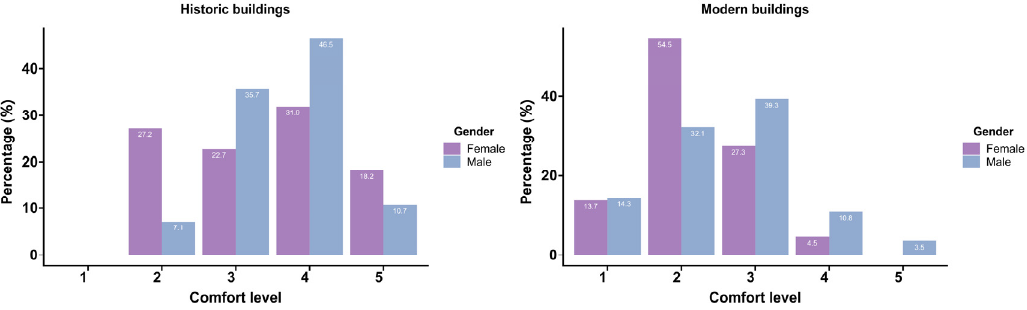
Figure 5. Percentage of evaluation levels by gender.